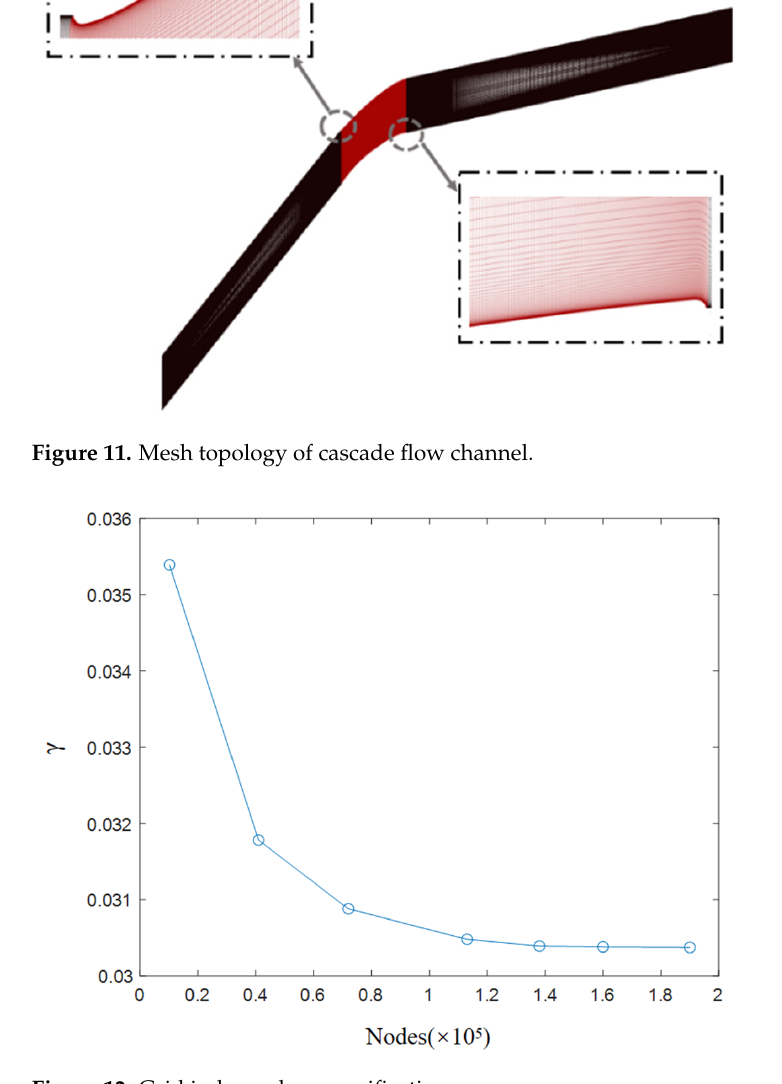
( b ) Figure 15. Turbulence intensity and total pressure contours near the section surface. ( a ) Turbulence intensity; ( b ) total pressure. The flow near the surface of the transonic compressor cascade is mainly turbulent. Thus, the loss due to energy dissipation of turbulence occupies a significant part. A large quantity of energy dissipates in the flow field and the local total pressure reduces, thus increasing the total pressure loss coefficient. Microgroove polyurethane coatings achieve turbulence control by altering the flow in the near-wall region. As shown in Figure 10, the turbulence control of different surface structure gives different impacts on the total pres- sure loss coefficient 𝛾 (cid:3036) of the transonic compressor cascade. The reason is that the ordered